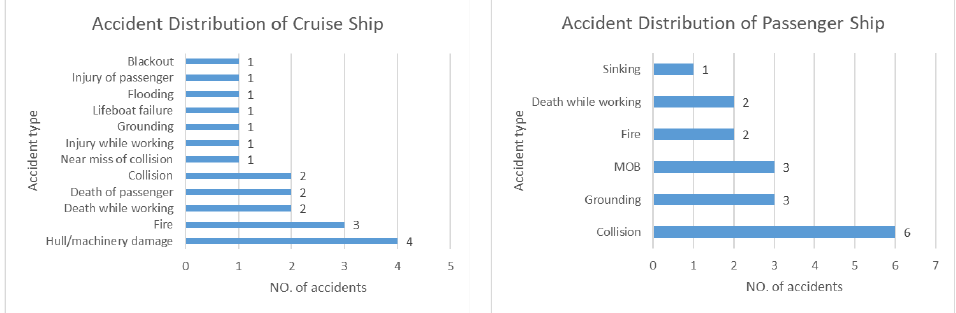
Figure 10. Accident distribution of bulk carriers ( left ) and fishing vessels ( right ).